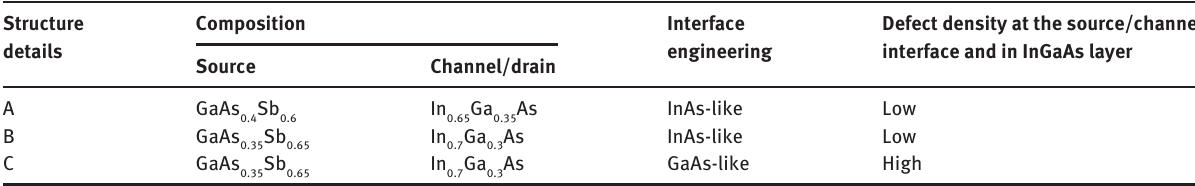
Table 3 Summary of composition and defect density difference of TFET structures studied